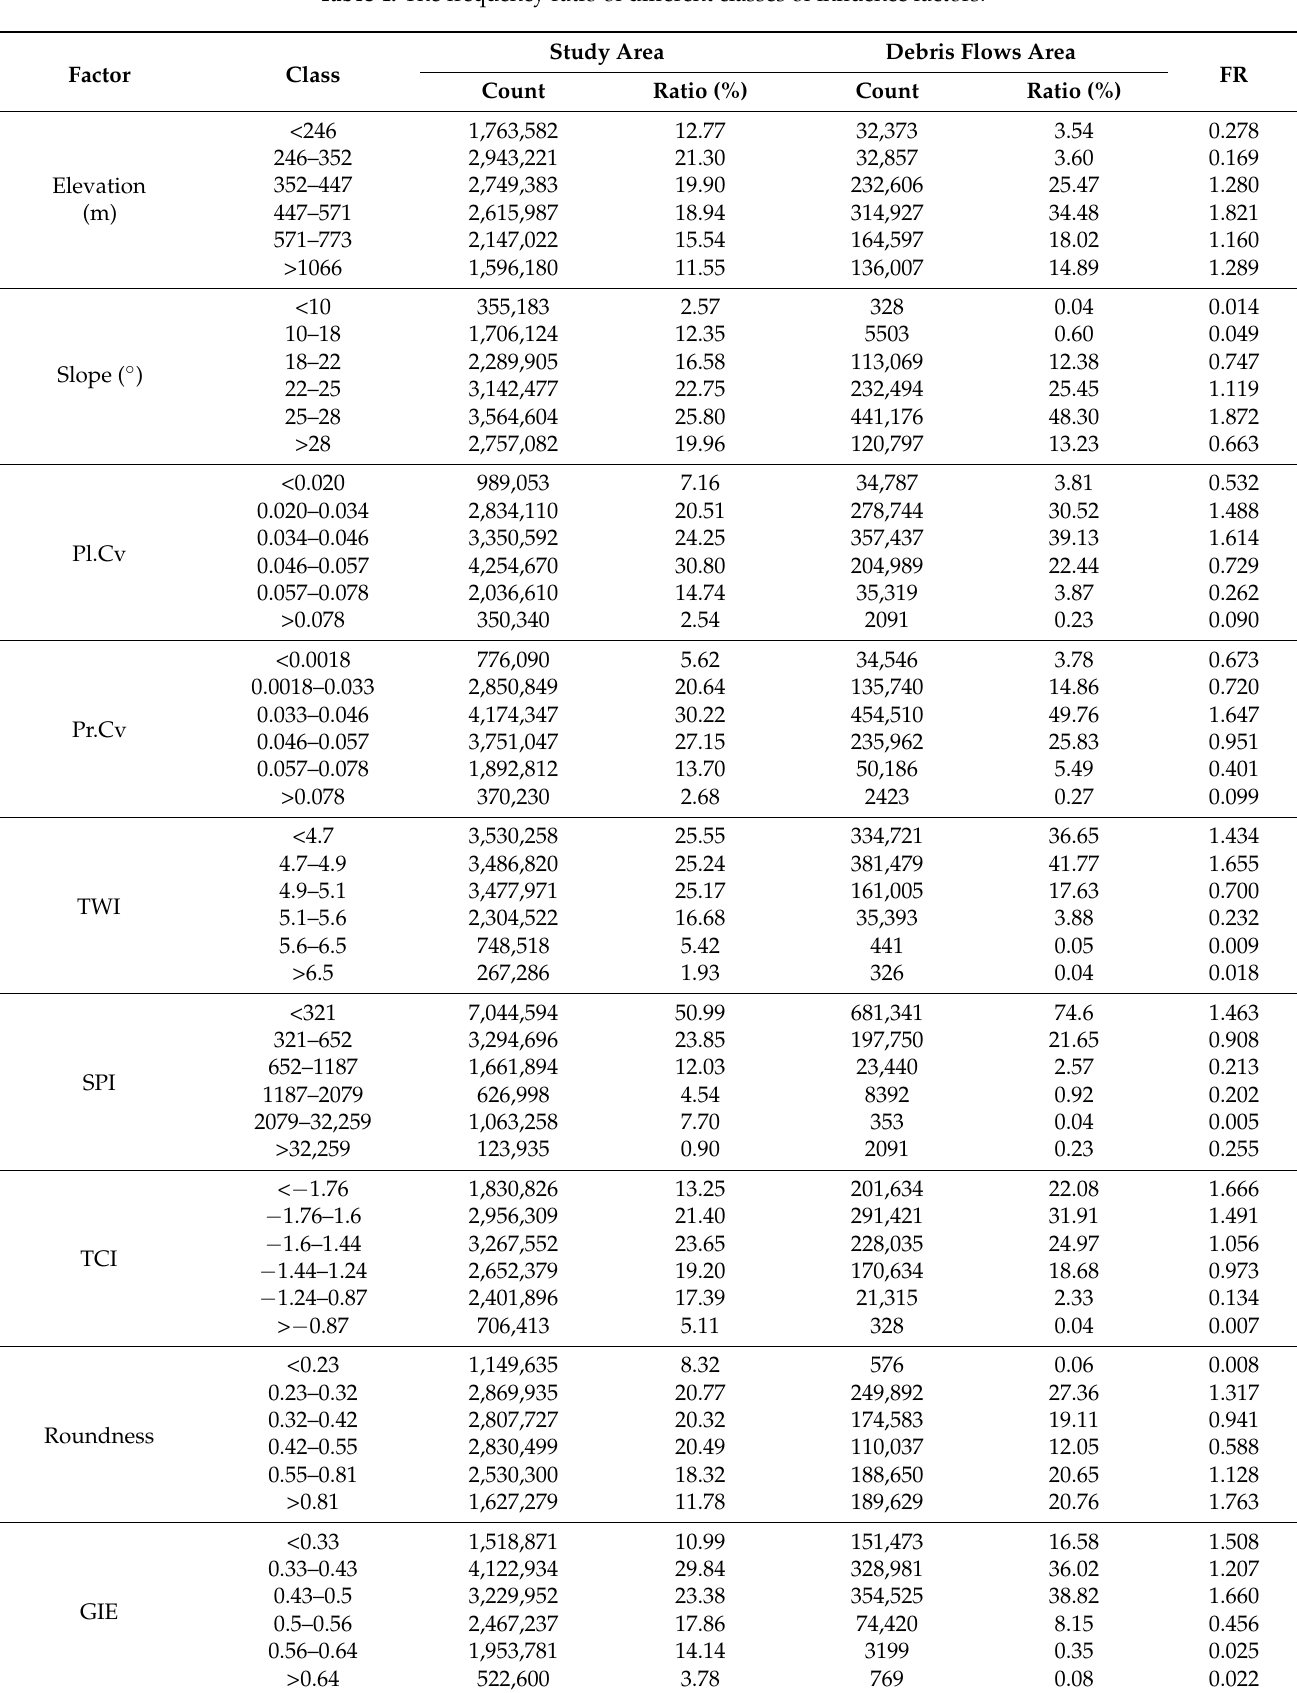
Table 4. The frequency ratio of different classes of influence